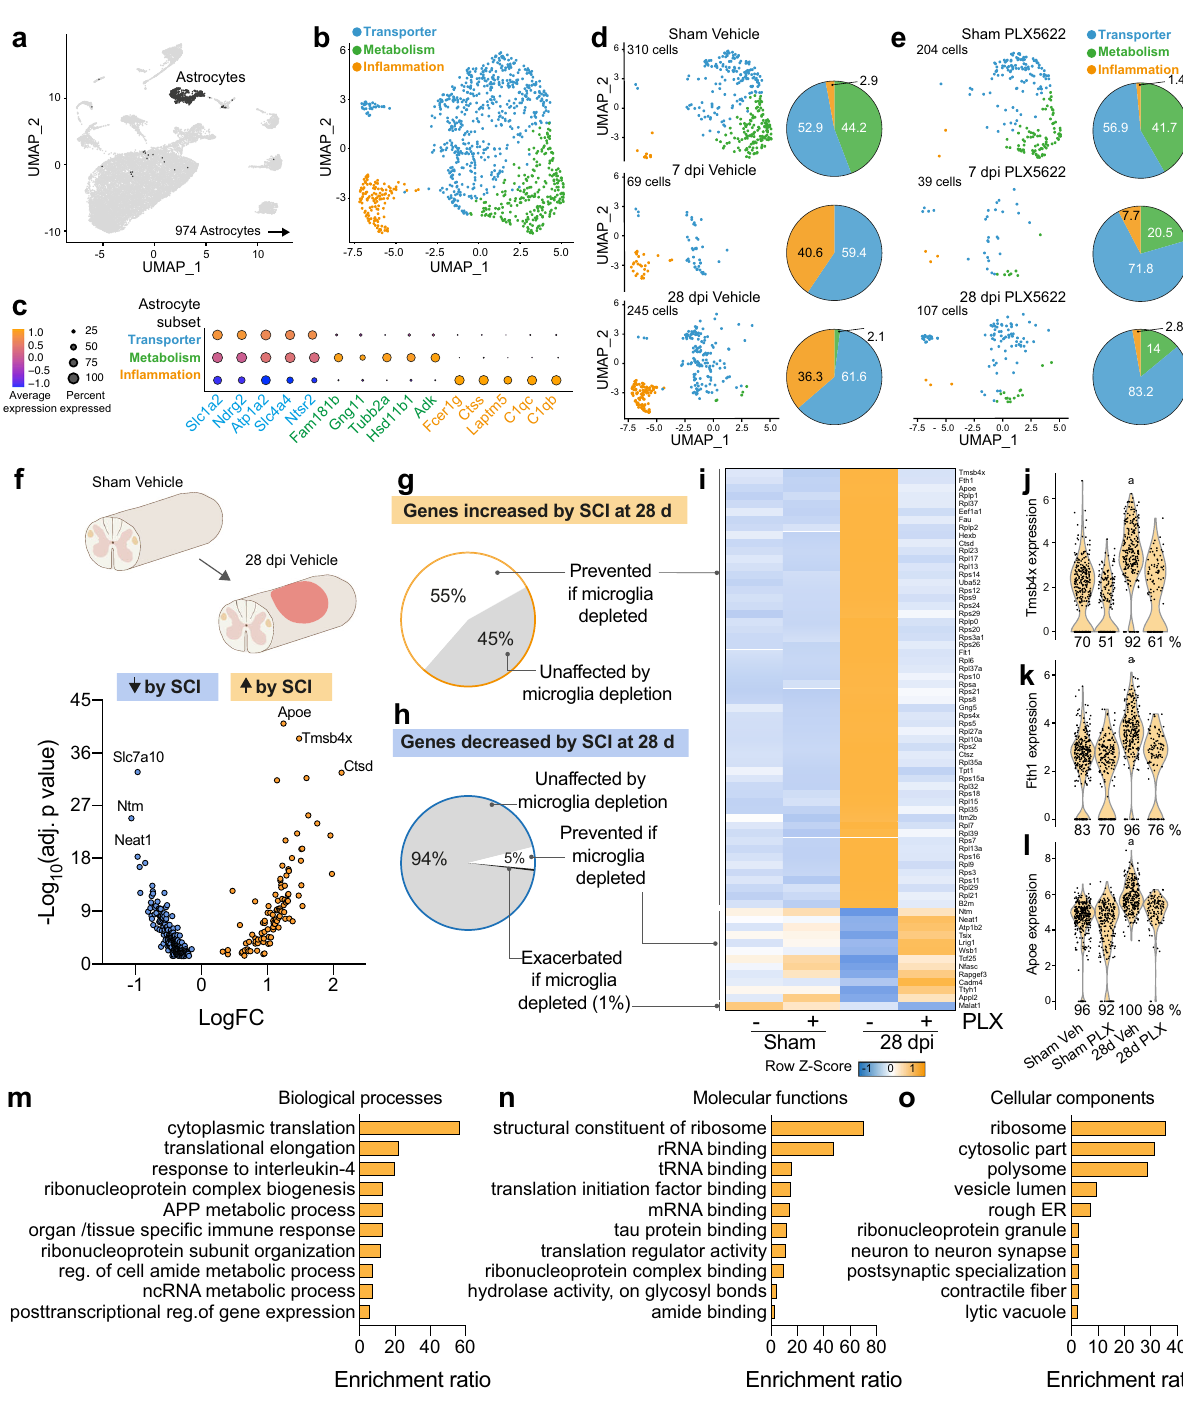
processreg. expressionncRNA metabolic reg.of gene Fig. 7 Microglia depletion impairs SCI-induced transcriptional changes in astrocytes. a Astrocytes were computationally isolated for analysis between experimental conditions. b Astrocytes were divided into three clusters based on dominant gene expression, and were characterized as: Transporter (green), Metabolism (blue), and In fl ammation (orange). c Dot Plot showing the top DEGs in each cluster. d , e UMAP plots showing astrocytes in the vehicle ( d ) and PLX5622 ( e ) conditions. The In fl ammation astrocyte subset increases proportion over time post-SCI only when microglia are present. Numbers in pie charts show each subset as a percent of total astrocytes in each group. f To determine how microglia depletion affected long-term SCI-induced changes in astrocytes, we compared 28dpi astrocytes to sham vehicle astrocytes. Select genes are labeled. g Of all the genes increased in astrocytes at 28dpi, 55% failed to increase if microglia are absent. h Of all the genes decreased in astrocytes at 28dpi, 5% failed to decrease if microglia are absent. i : Heatmap showing SCI-dependent and microglia-dependent astrocyte genes. j – l Violin plots showing the fi rst 3 genes in h . The percentages under each violin indicate the percent of cells in the group that express the gene a . p adj <0.0001 compared to other groups, Wilcox rank-sum test, n = 107 – 310 astrocytes per group pooled from 3 – 4 mice per group. m – o Astrocyte genes increased by SCI and reversed by microglia depletion were entered into gene ontology (GO) term analysis using WebGestalt. Astrocyte biological processes ( l ), molecu l ar functions ( m ), and cellular components ( n ) related to translation, cell proliferation, metabolism, and in fl ammation were impaired by microglia depletion. Source data are provided as a Source Data fi